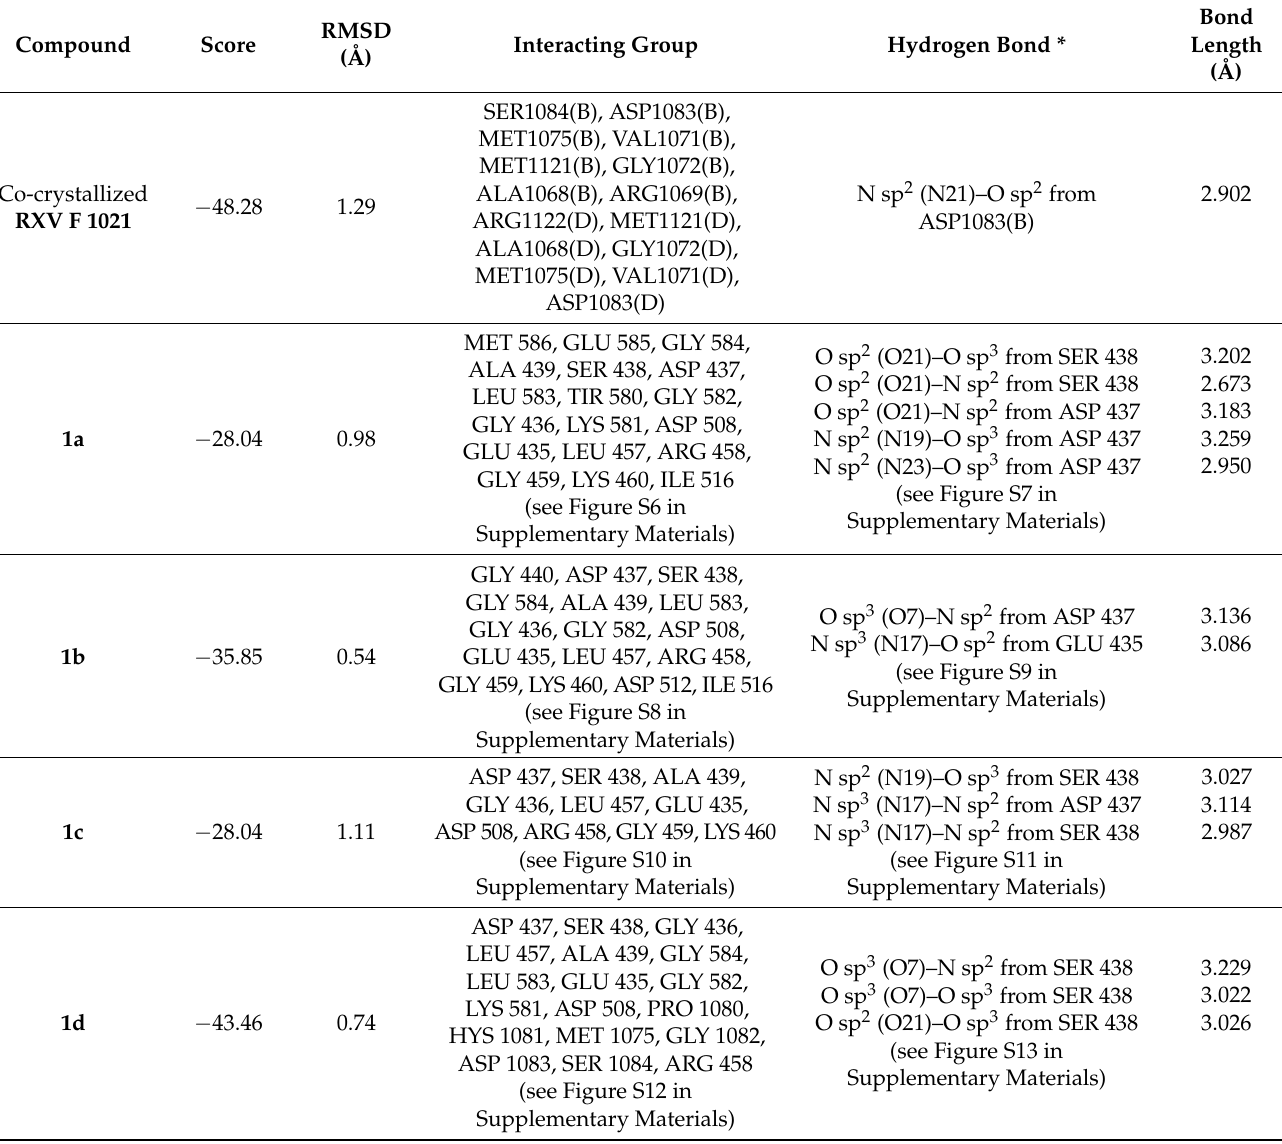
Table 8. List of intermolecular interactions between the ligand molecules docked with 2XCS ( S. aureus DNA gyrase B, chain F) using CLC Drug Discovery Workbench